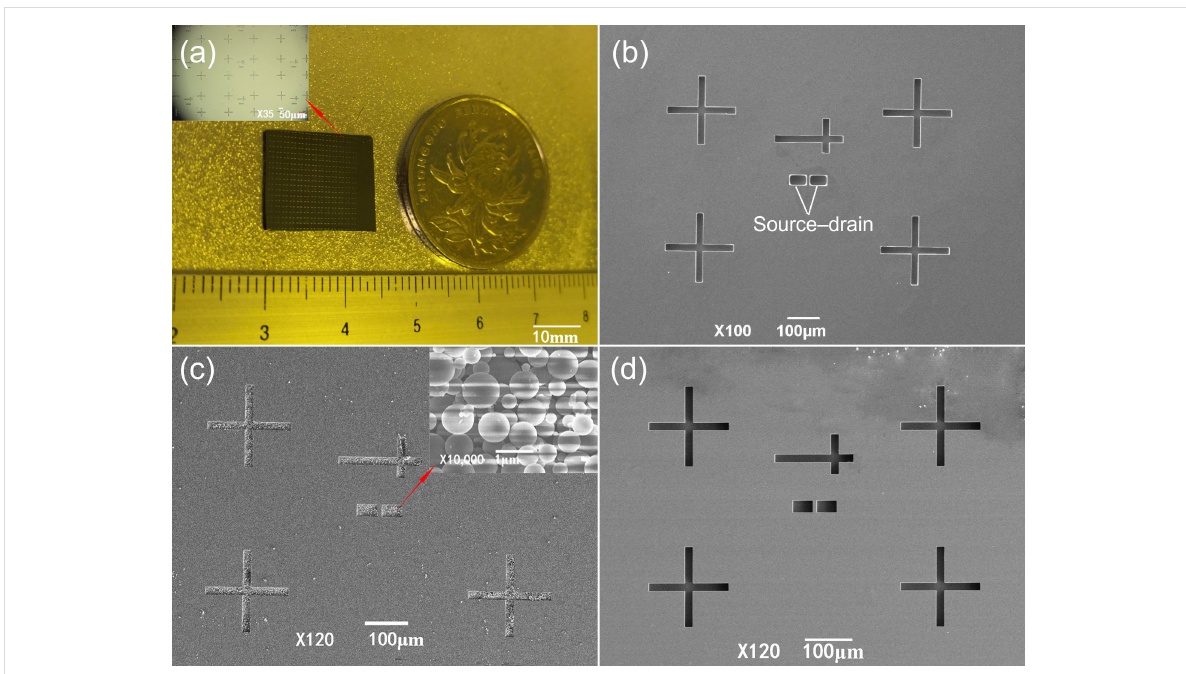
Figure 2: Surface morphology of the silicon template. (a) Physical appearance of the silicon template with source–drain groove. (b) Groove morpholo- gy before filling with SiO 2 nanoparticles. (c) Groove morphology after filling with SiO 2 nanoparticles and distribution of nanoparticles in the groove. (d) Groove morphology of the silicon template after peeling off the PDMS film.